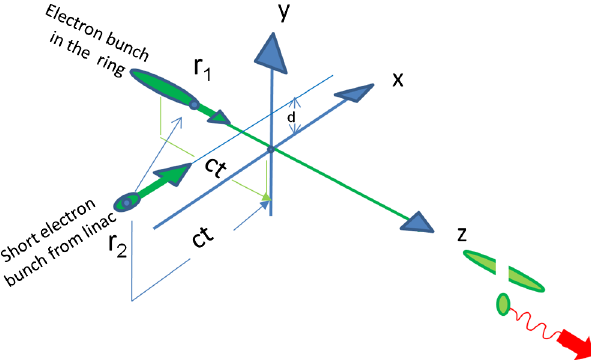
FIG. 1. Illustration of electron beam